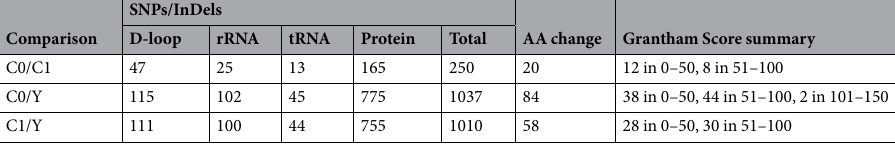
Table 1. Mitogenome divergences across the three primary